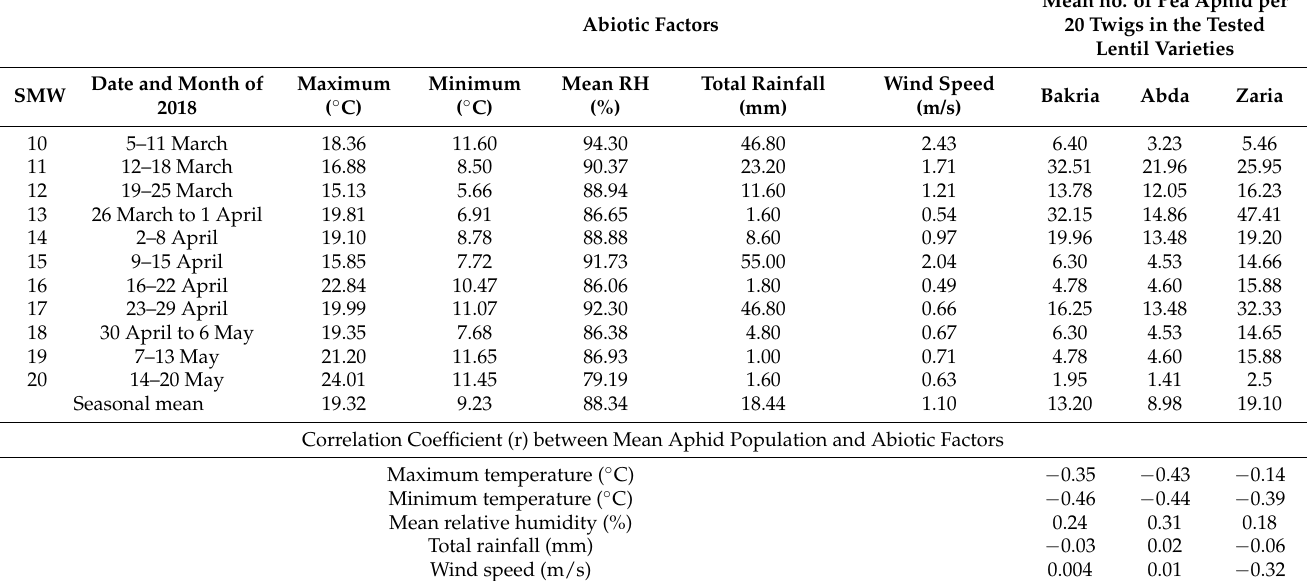
Table 7. Influence of weather factors on mean number of pea aphid, A. pisum , per 20 twigs of three lentil varieties during 2017–2018.